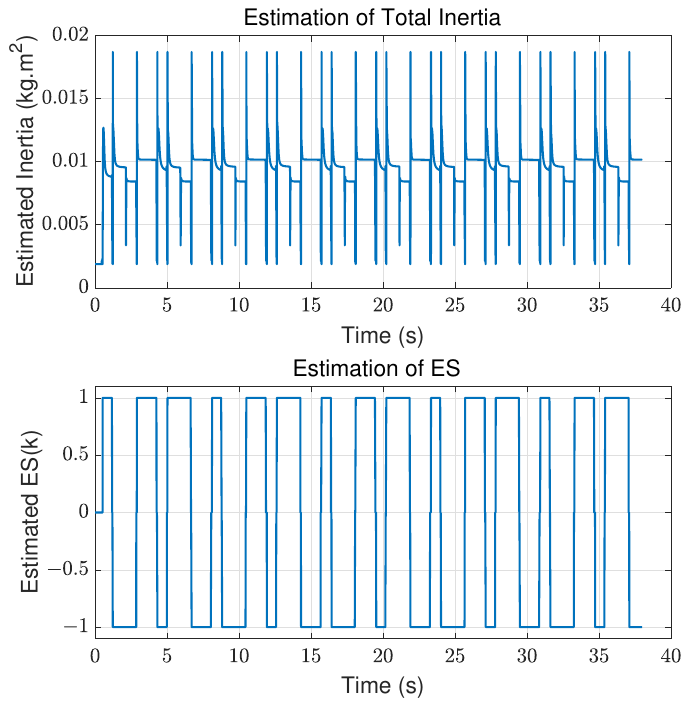
Figure 11. Upper : estimation of the total inertia carried by the motor shaft. Lower : estimation of the mechanical engagement status ES